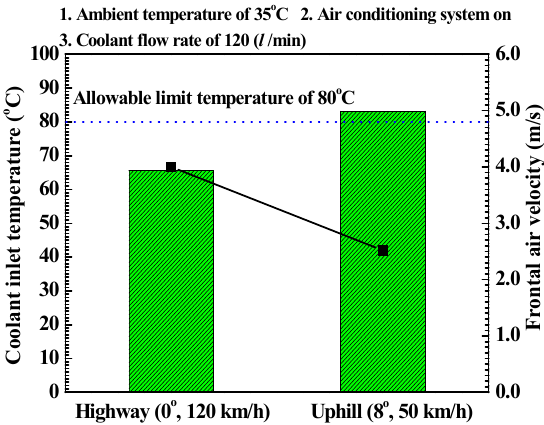
Figure 7. Cooling performance of the stack thermal management system under highway and uphill driving modes.